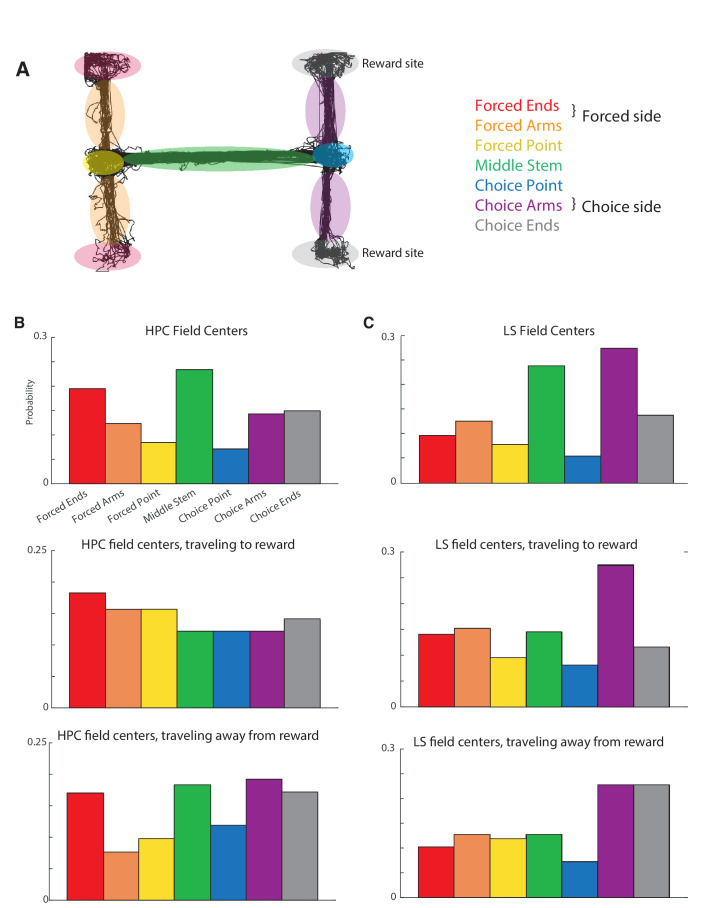
Subdivided place field locations in HPC and LS.(A) Schematic showing track divisions (B) Field locations in HPC. Top: for the full track, middle: traveling to reward, bottom: traveling away from reward. (C) Same, but for LS.